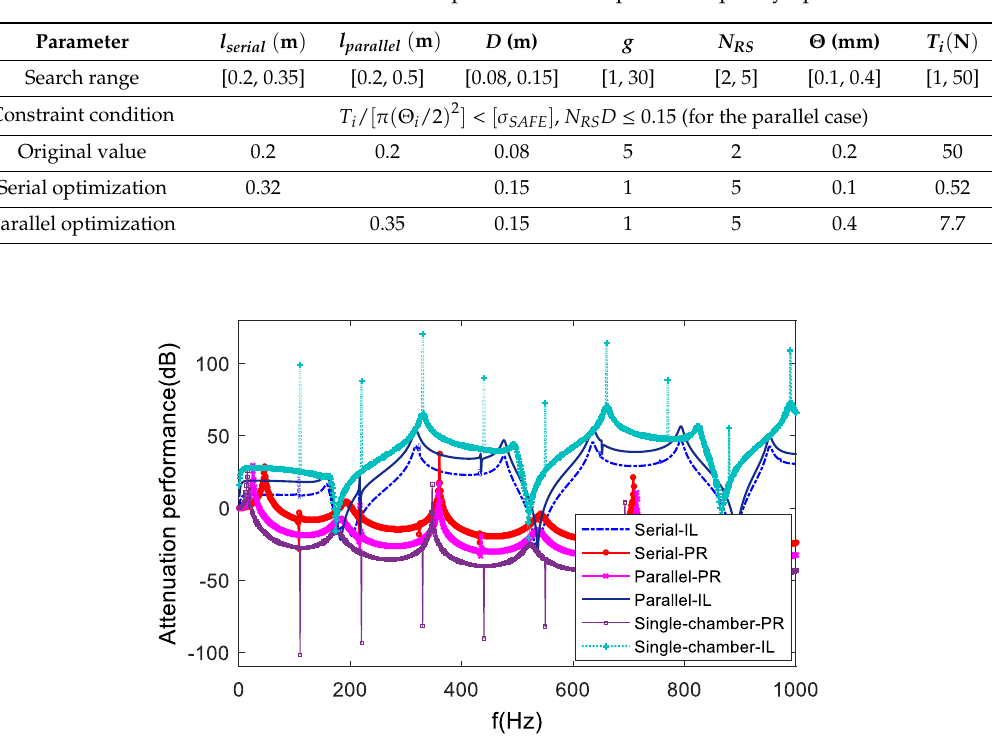
Figure 14. Specific frequency optimization for serial and parallel combinations of RSHPA (220 Hz).